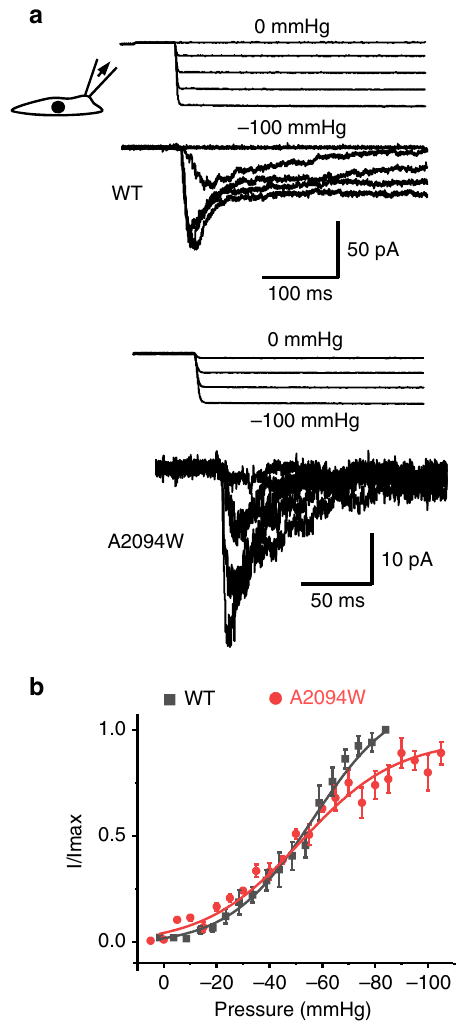
Fig. 3 The Yoda1-insensitive A2094W mutant is mechanosensitive. a Example of pressure-elicited ionic current traces for mPZ1 WT and the A2094W mutant obtained in transfected Δ PZ1 cells clamped at − 80 mV. For clarity, only few traces are shown. b Mean I/Imax values plotted for WT ( n = 8) and the A2094W mutant ( n = 6) for comparison. Data are collected from n cells. Lines correspond to curve fi tting using a Boltzmann equation. Source data are provided as a Source Data fi le. Error bars